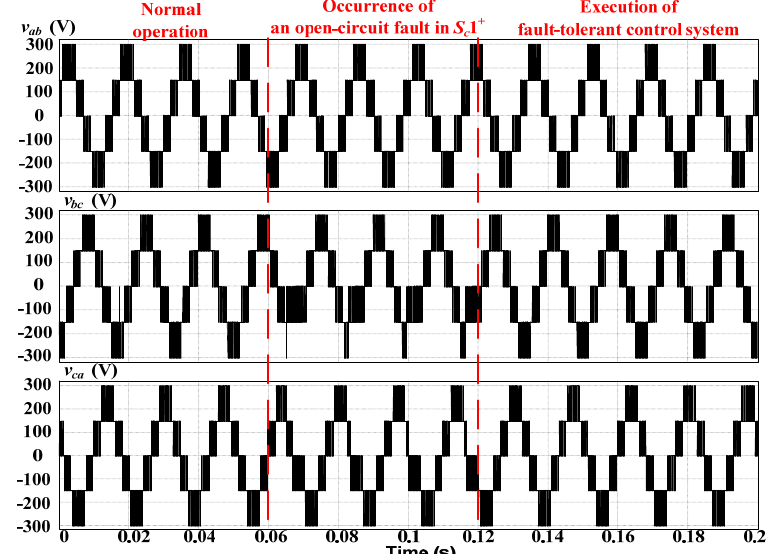
Figure 15. The output voltage of S c 1 + after the occurrence of an open-circuit fault and the activation of fault-tolerant control.